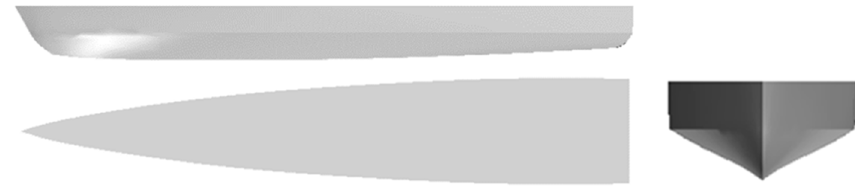
Figure 2. The geometry of the monohull.